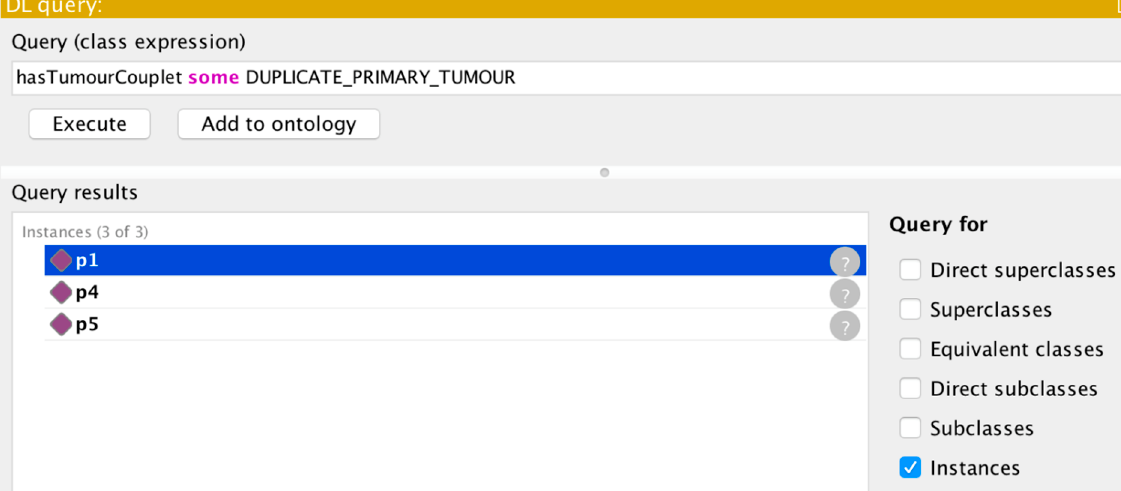
Figure 11. Results of a DL query for entities that have duplicate primary tumours.